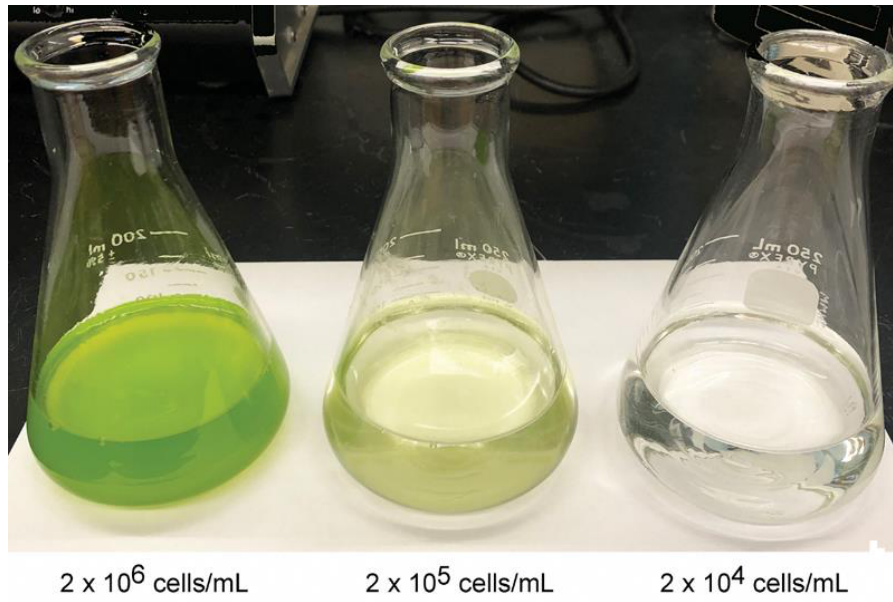
Figure 6. Representative cultures of C. reinhardtii at 2 × 10 6 , 2 × 10 5 , and 2 × 10 4 cells/mL, respectively. A complemented transformant of CC-373 was grown to late log phase in TAP medium, centrifuged, resuspended in dH 2 0, and diluted with dH 2 0 to generate the 3 flasks shown in the figure.